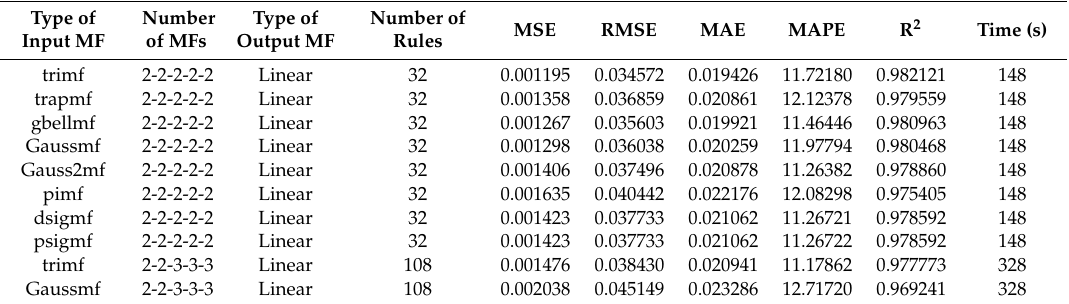
Table A1. Di ff erent configurations of the selected ANFIS architectures regarding linear output